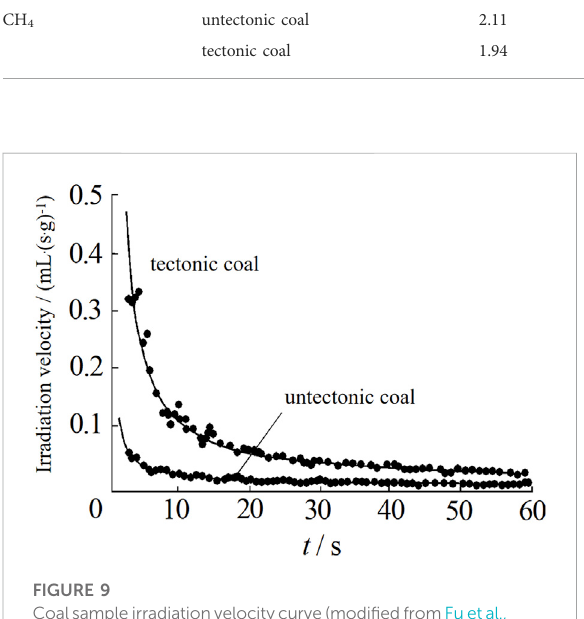
FIGURE 9 Coalsampleirradiationvelocitycurve(modi fi edfromFuetal.,